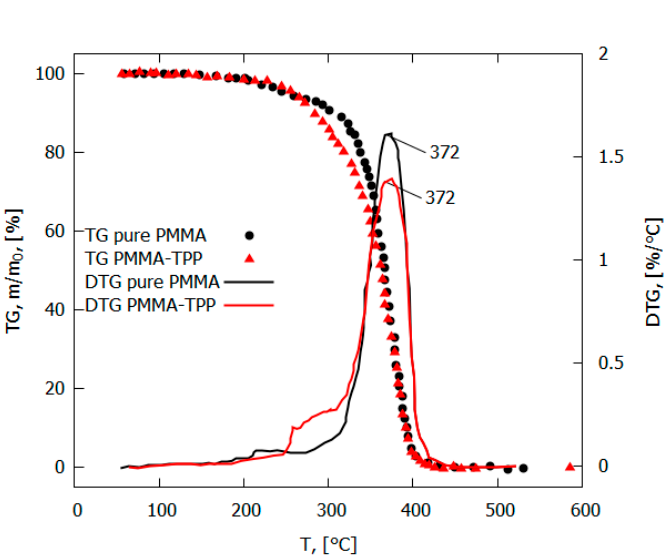
Figure 9. TGA and DTG of PMMA and PMMA-TPP in inert medium (10